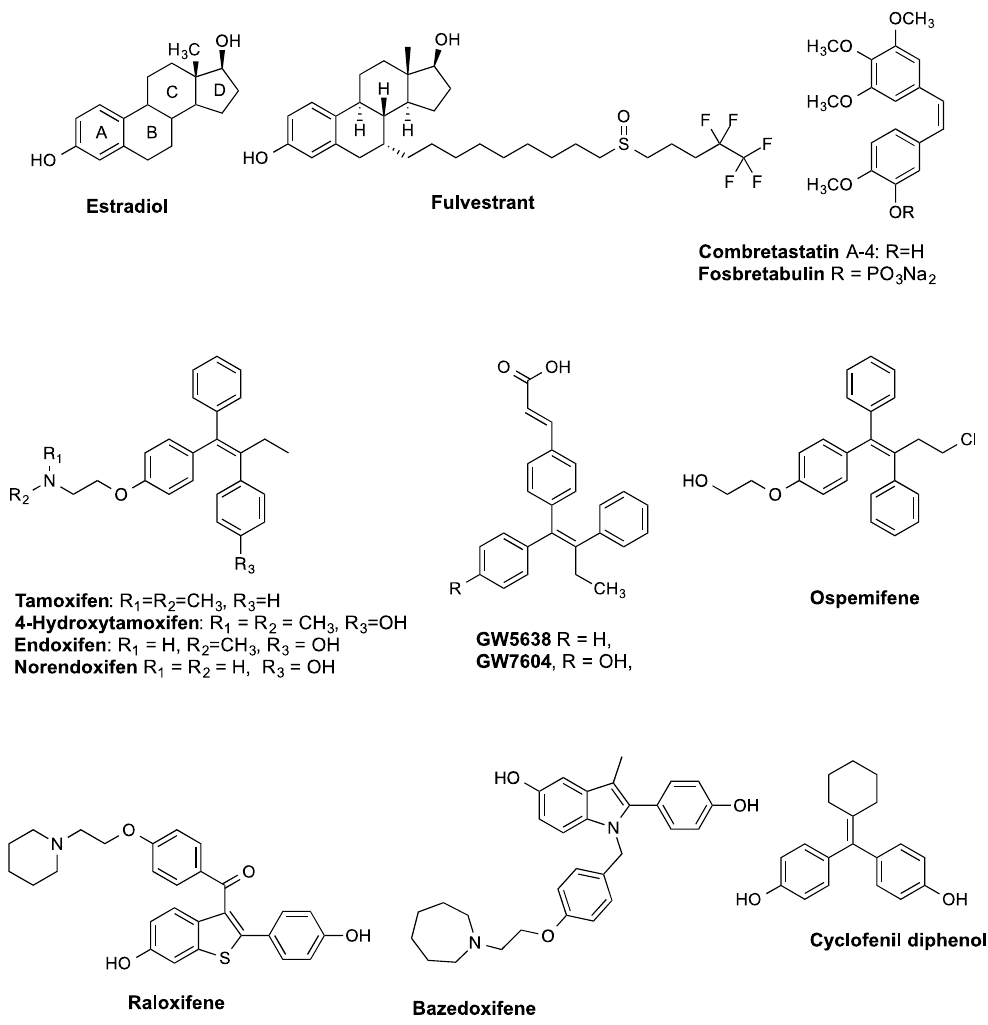
Figure 1. Estradiol, selected ER antagonists and combretastatin A-4.